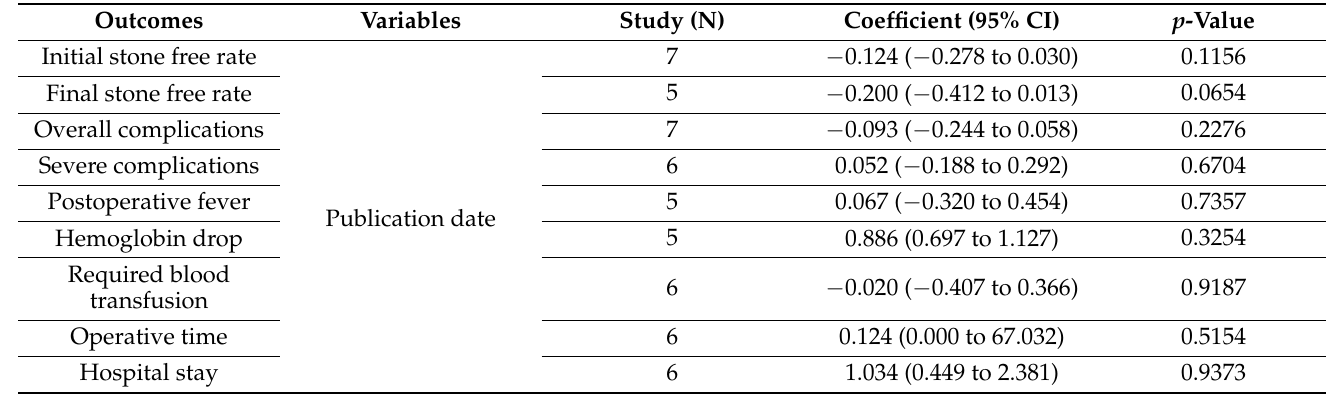
Table A8. Summary of the Result of Meta-Regression Analysis Regarding Outcome Measurements and Publication Date.